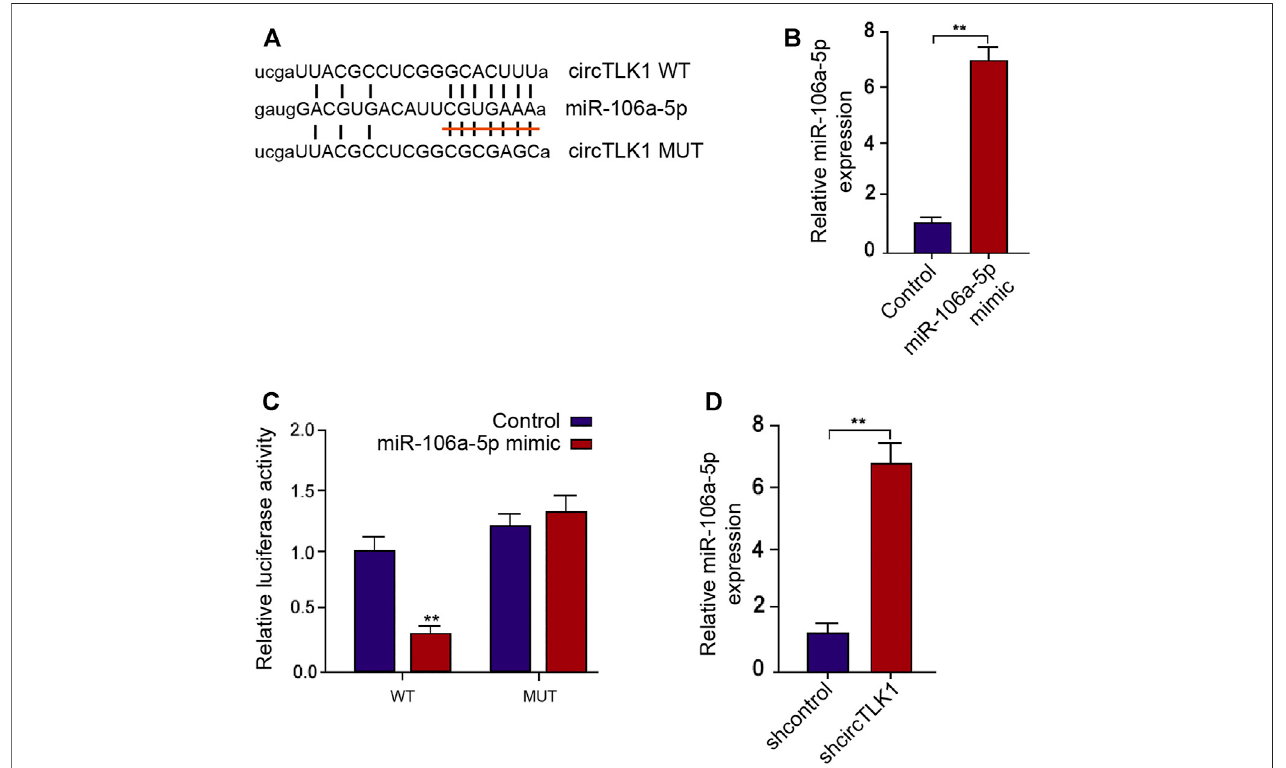
FIGURE4| CircTLK1sponges miR-106a-5p inHK-2cells. (A) BioinformaticanalysisusingENCORIdatabase.ThesequencesofmiR-106a-5p, wild-typecircTLK (WT), and mutant circTLK (MUT) are shown. (B , C) HK-2 cells were treated with miR-106a-5p mimic. (B) qPCR assays of miR-106a-5p expression. (C) Luciferase reporter gene assays of wild-type circTLK (WT) and mutant circTLK (MUT) luciferase activities. (D) HK-2 cells were treated with circTLK1 shRNA. The qPCR assays of miR-106a-5p expression, mean ± SD, ** P <